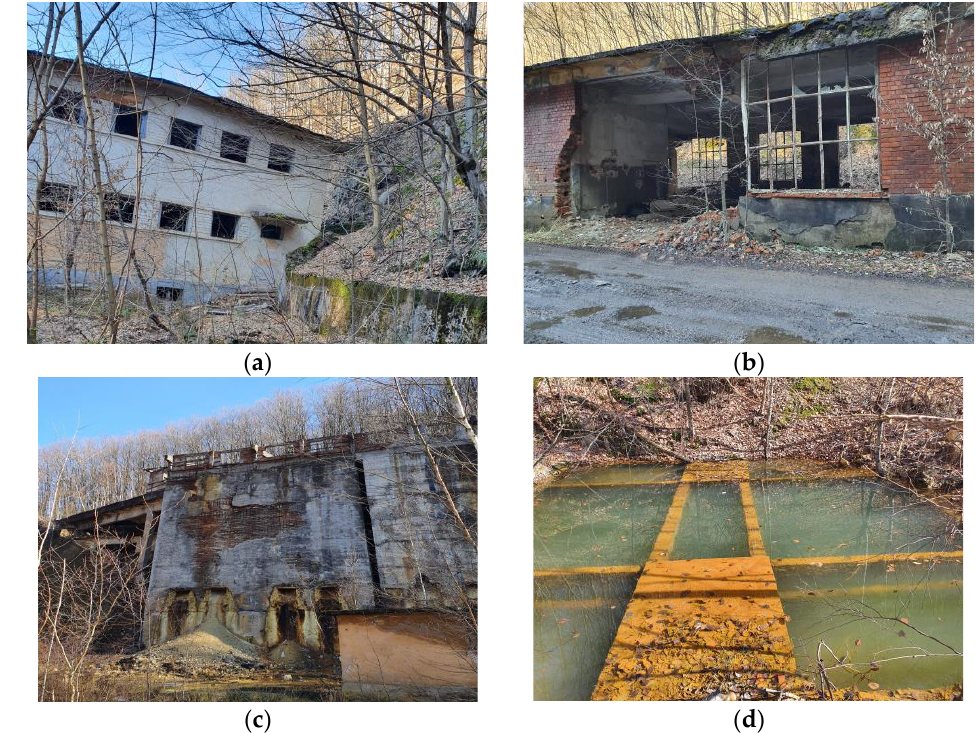
Figure 5. The ruins of the mining exploitation in Ilba, Romania (photos: I.A.P.): ( a ) Ruins of the administrative building; ( b ) Decommissioned building; ( c ) Silos with sterile material; ( d ) Basins with water.